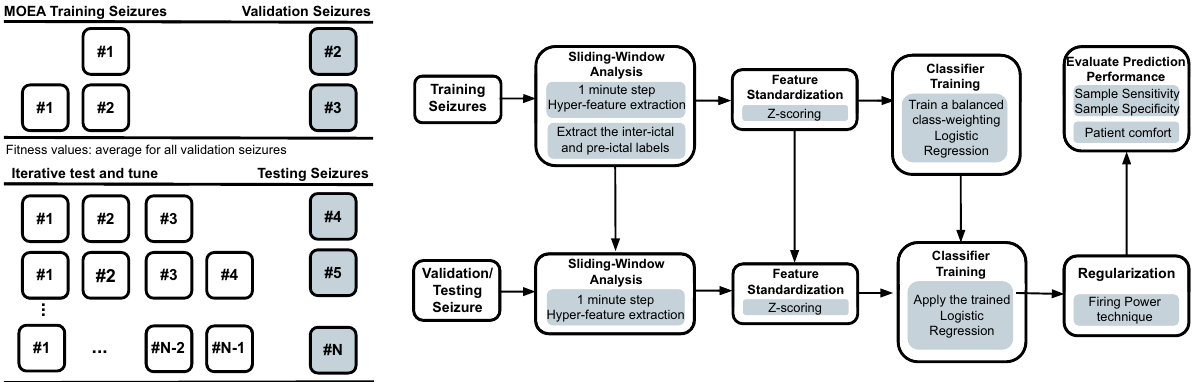
Figure 4. An illustrated scheme of the iterative retraining and validation in the MOEA input seizures. With the selected hyper-features, an iterative test and tune procedure is made ( a ). Scheme for one tested seizure on the fitness function ( b